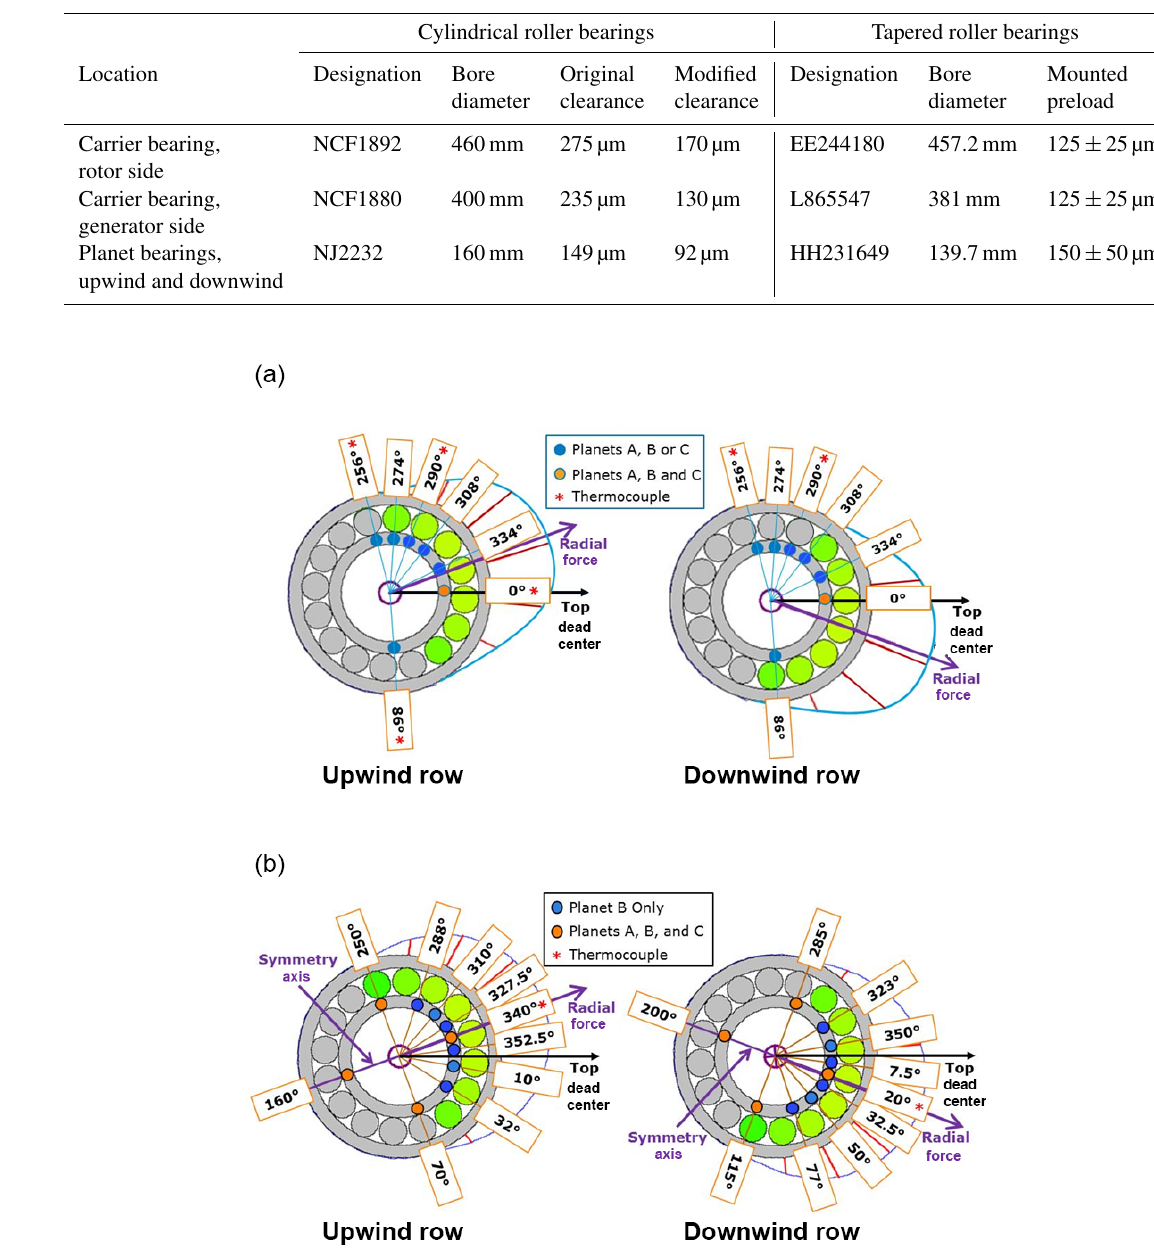
Figure 4. Planet bearing load measurements for the gearbox with CRBs (a) and TRBs (b) .